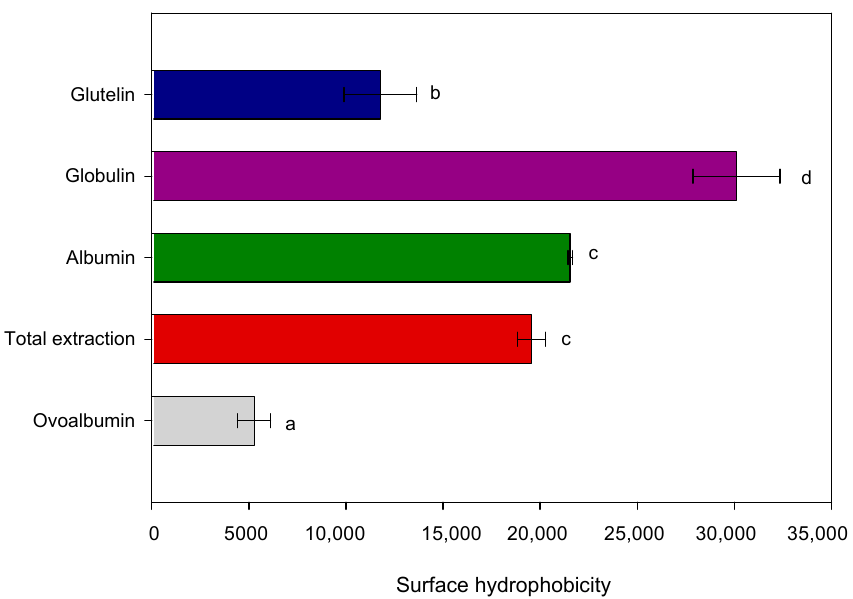
Figure 5. Surface hydrophobicity of proteins extracted from chickpea flour. Different letters (a–d) indicate significant differences ( p < 0.05) between samples. Error bars indicate the mean and standard deviation of triplicates.